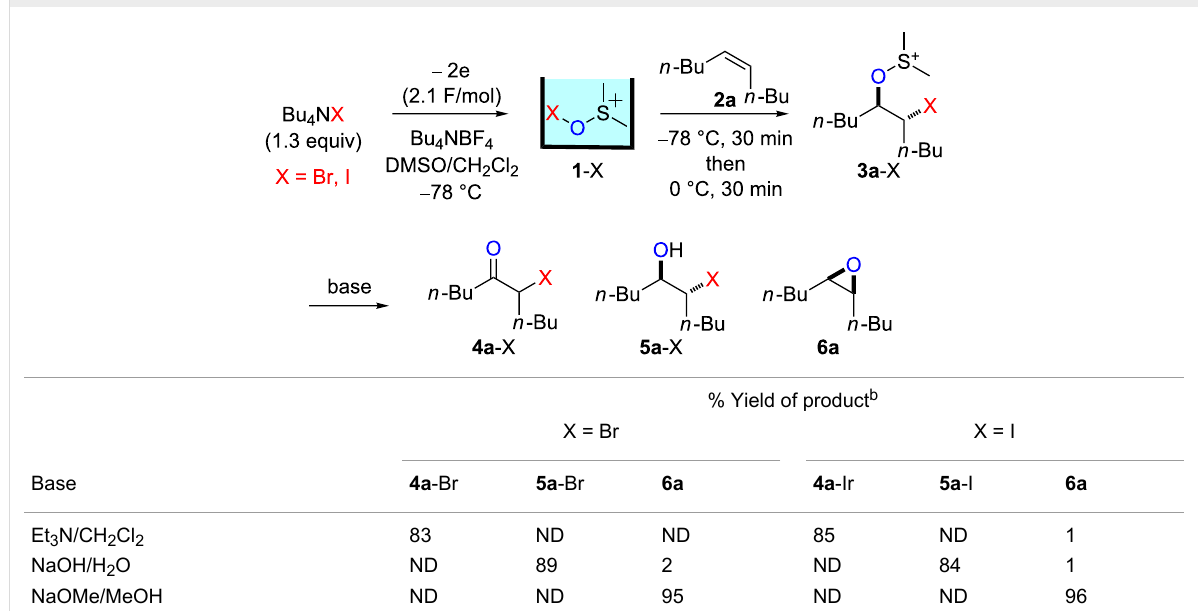
Table 1: Reaction of 3a -X (X = Br, I) with different bases.